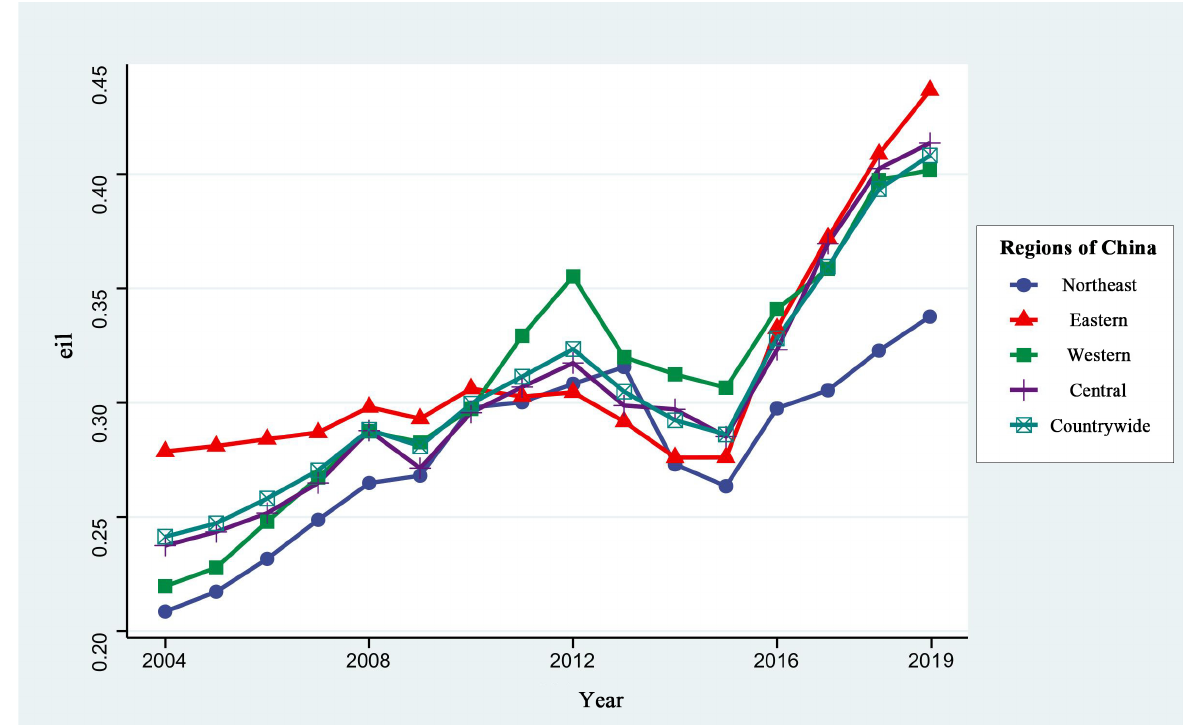
Figure 3. Changes in GUEIL nationwide and by region from 2004–2019.